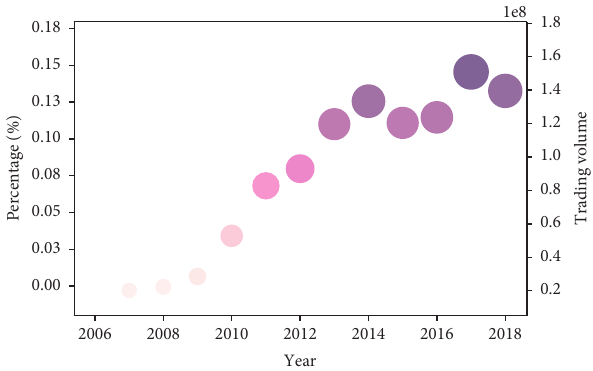
Figure 1: Trading volume of VIX